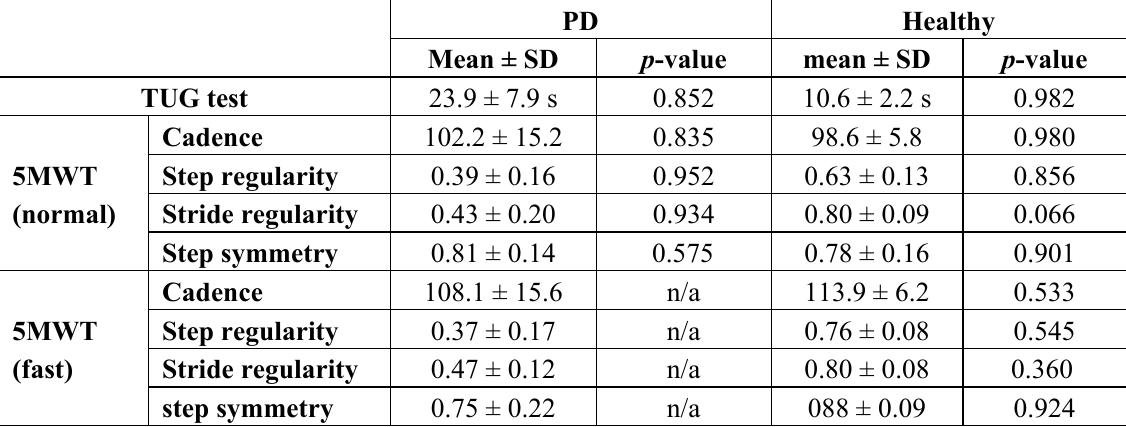
Table 1. Gait cycle parameters derived from the